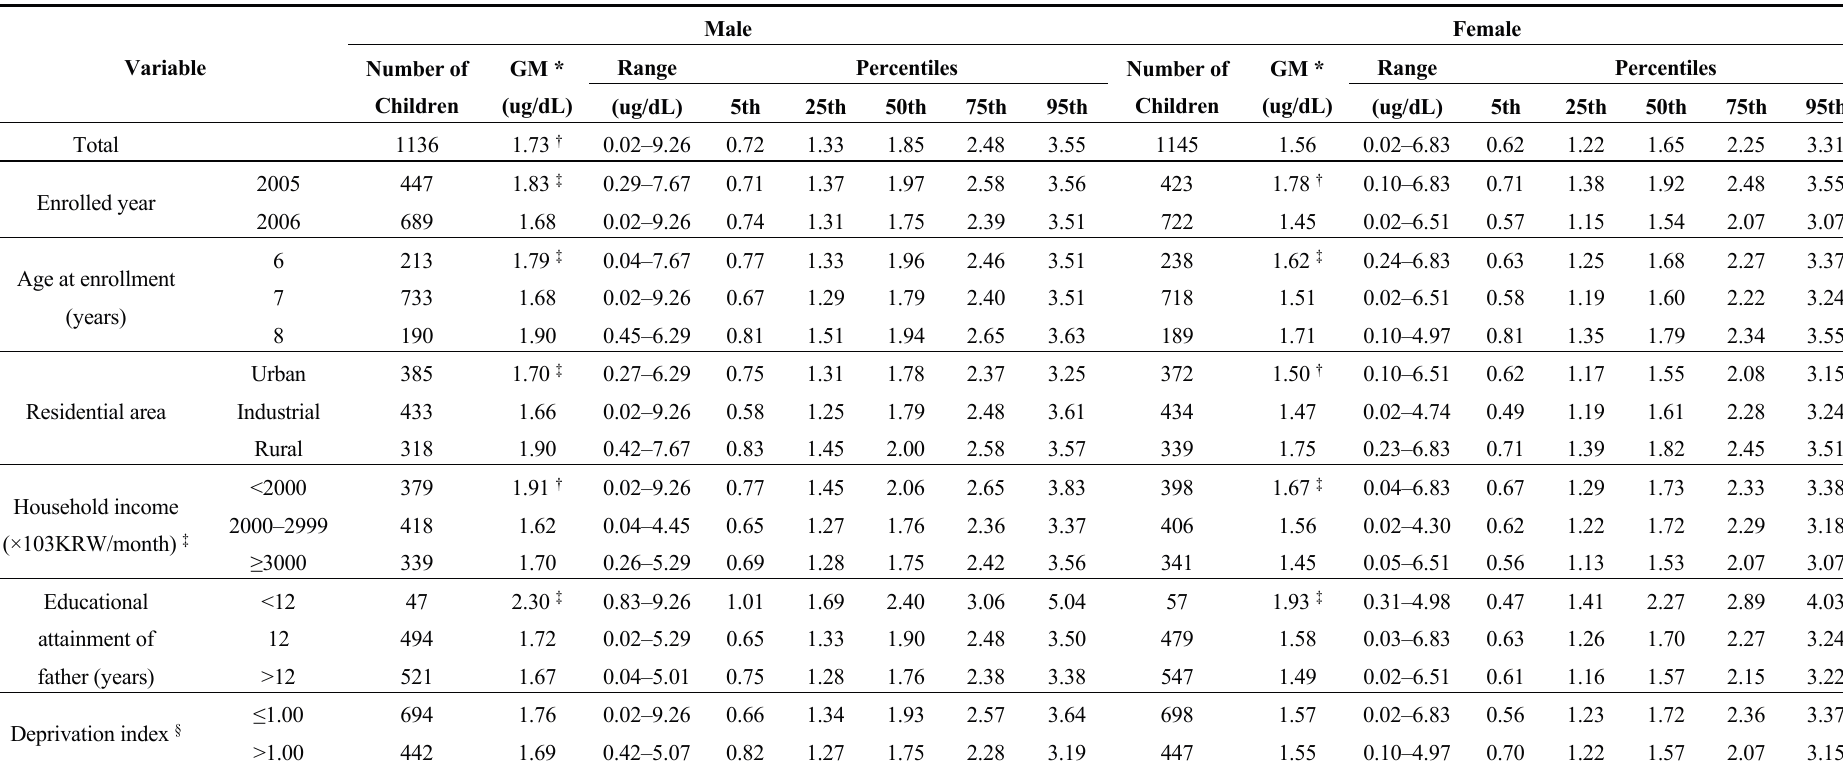
Table 1. Blood lead distributions at enrollment according to basic characteristics and socioeconomic positions of 2281 children, CHEER, 2005–2006, Korea. Male Variable